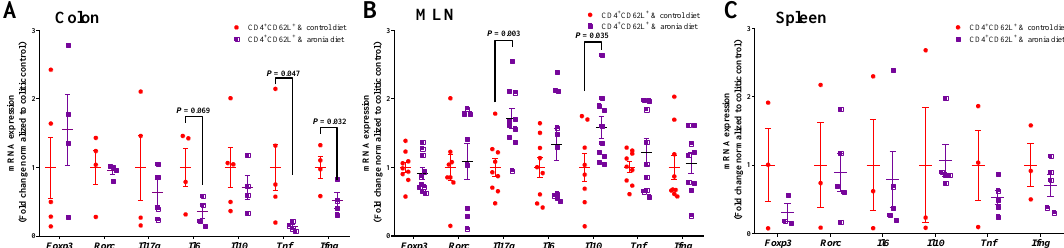
Figure 2. Aronia consumption downregulates mRNA expression of pro-inflammatory cytokines and up-regulates anti-inflammatory cytokines. Splenic CD4 + CD62L + cells from C57BL/6J mice were transferred to Rag1 -/- mice. Mice consumed the AIN-93M diet (colitic control) or aronia-supplemented diet for five weeks. A third group of Rag1 -/- mice received splenic CD4 + cells, consumed AIN-93M diet and served as the non-colitic control. The mRNA expressions of transcription factors of Foxp3 (forkhead box P3) and Rorc (RAR-related orphan receptor gamma), and cytokines of Il17a (interleukin 17A), Il22 (interleukin 22), Il6 (interleukin 6), Il10 (interleukin 10), Ifng (interferon-gamma), and Tnf (tumor necrosis factors) in the ( A ) colon ( n = 4 – 5/group), ( B ) mesenteric lymph node (MLN) ( n = 8 – 10/group), and ( C ) spleen ( n = 3 – 5/group). The mRNA expressions were normalized to Eef2 (eukaryotic translation elongation factor 2) and Rplp0 (ribosomal protein large P0) genes. Data are means ± SEMs.